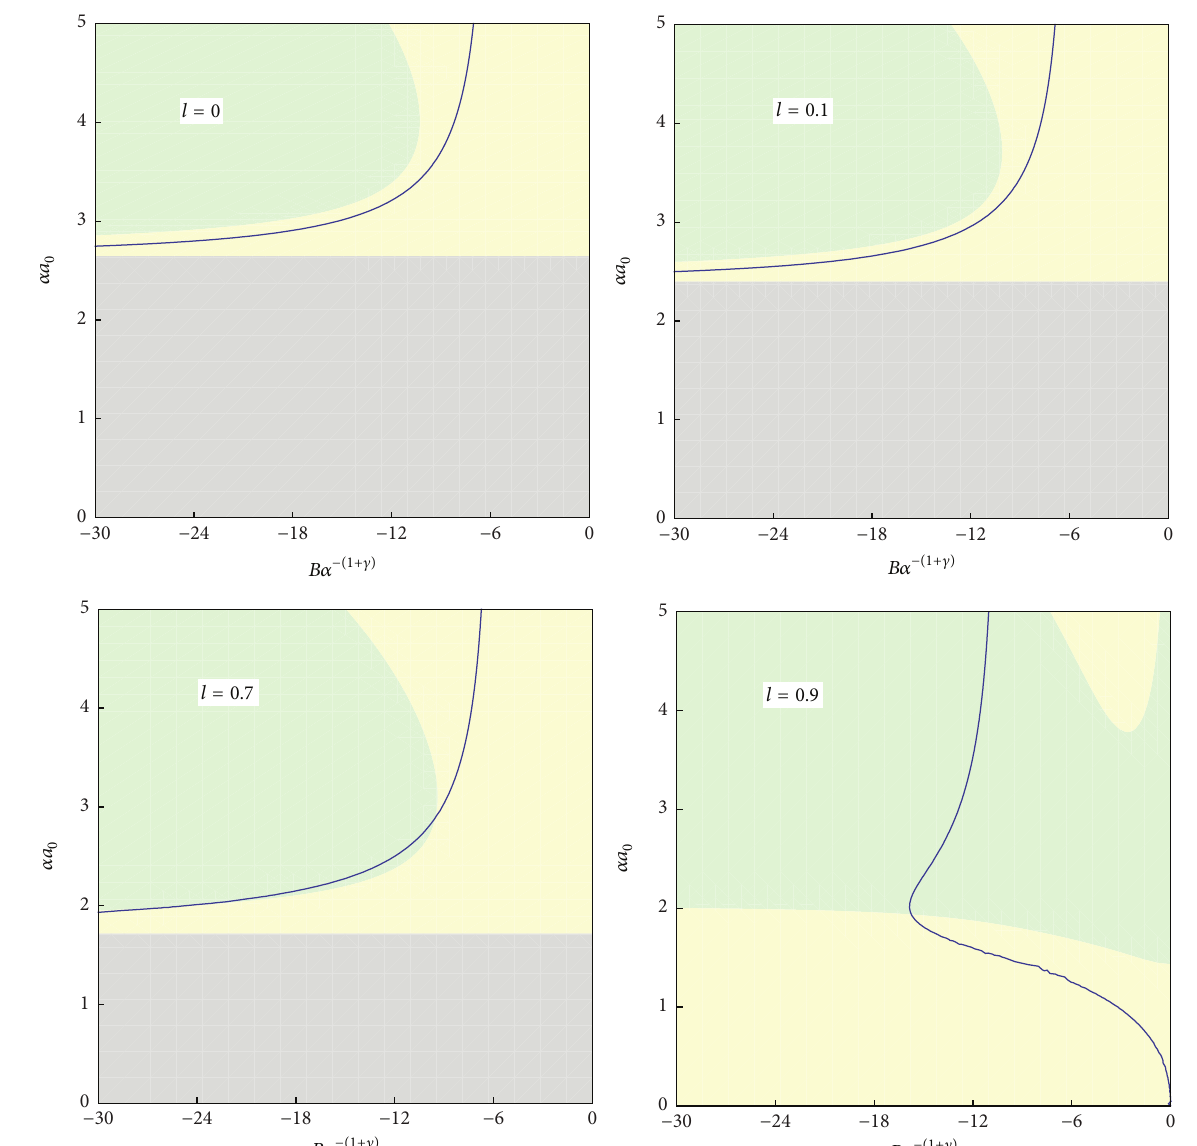
Figure 3: Plots for regular Hayward thin-shell wormholes by taking VDW quintessence with 𝛾 = −0.5 , 𝑀 = 1 , 𝛼 = 1 , and different values of Haywardparameter 𝑙 .Thestableandunstableregionsarerepresentedbygreenandyellowcolors,respectively,whilethegreyzonecorresponds to nonphysical region. Here, 𝐵𝛼 −(1+𝛾) and 𝛼𝑎 0 are labeled along abscissa and ordinate,